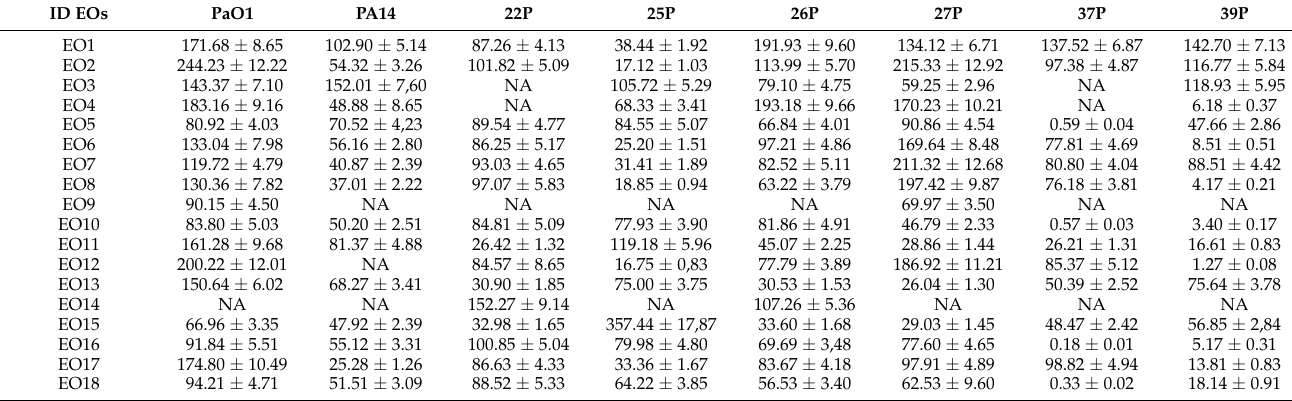
Table 1. Effect of EO on biofilm formation. Percentage of bacterial biofilm formation in the presence of each EO listed in Table S3 at a concentration of 1.00% v / v relative to untreated bacteria. Each data point is composed of four independent experiments, each performed with at least three